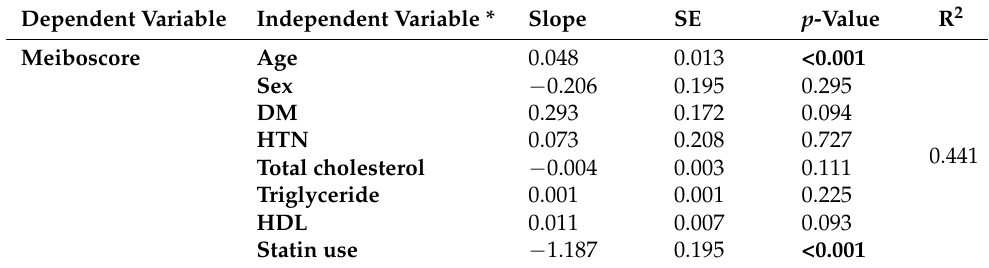
Table 3. A multiple regression analysis evaluating meiboscores as dependent